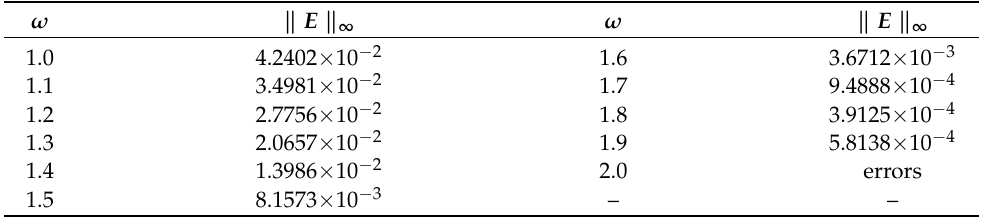
E Table 5. The errors ∞ of AAI algorithm based on domain decomposition with the different values of ω (cid:107) (cid:107) when l = m = s = 31, h = 1/30, n =